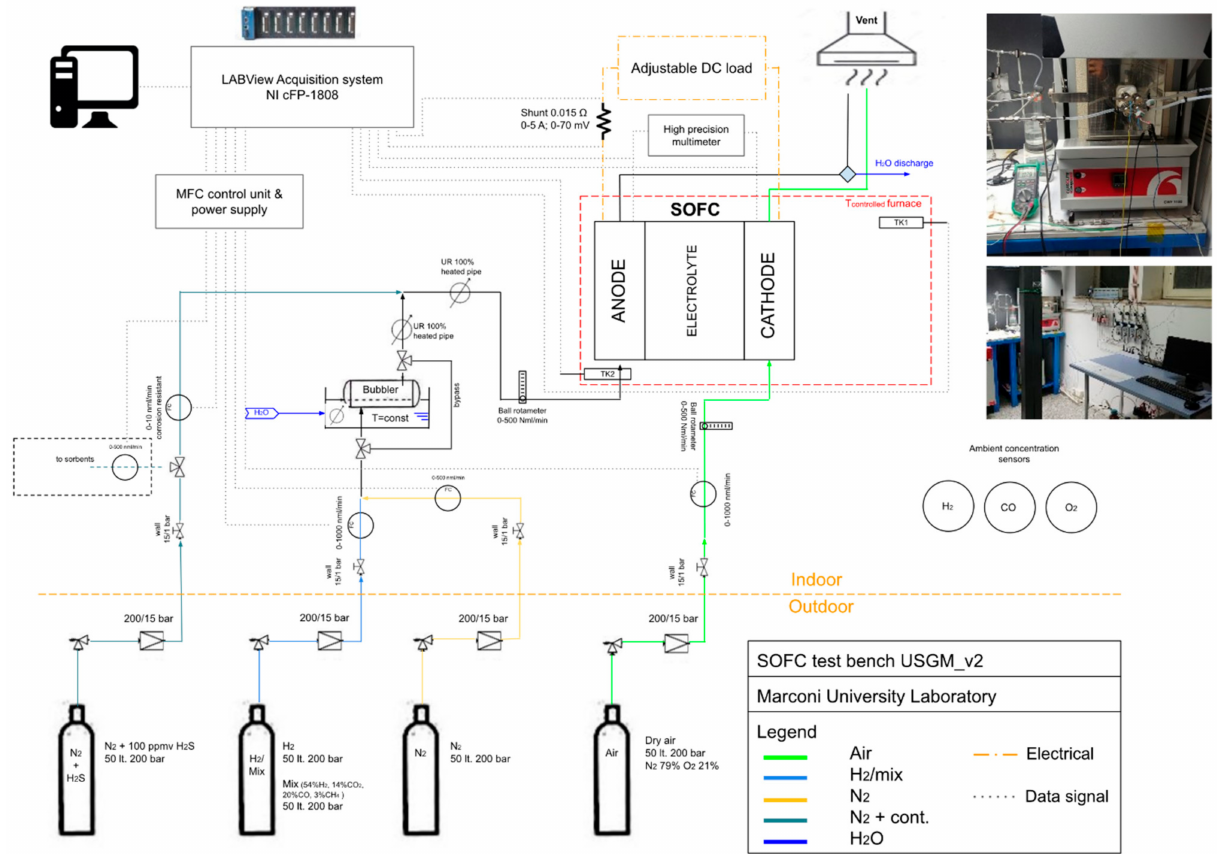
Figure 3. Experimental SOFC test bench setup